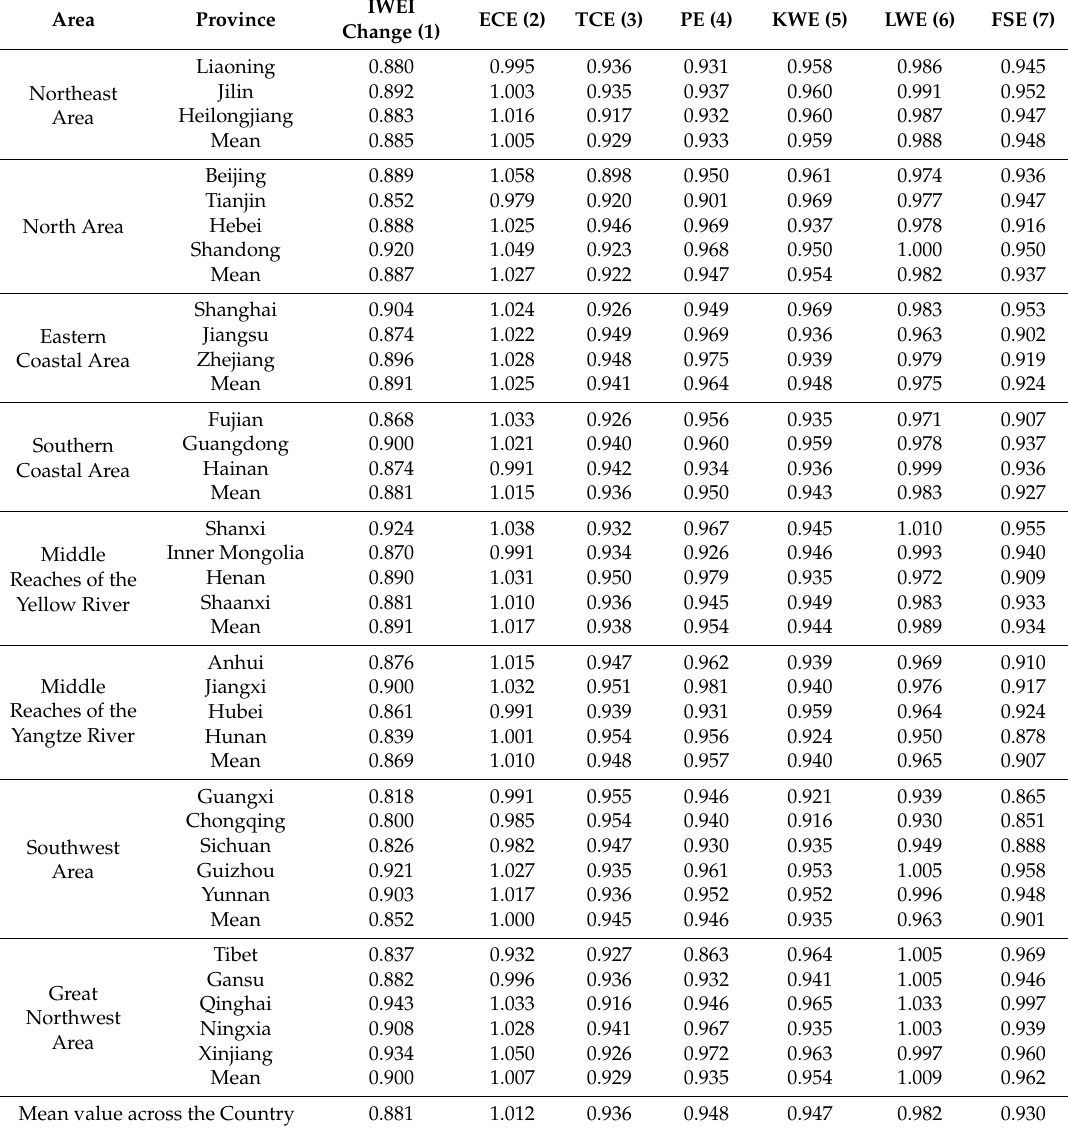
Table 3. Decomposition results of factors affecting IWEI